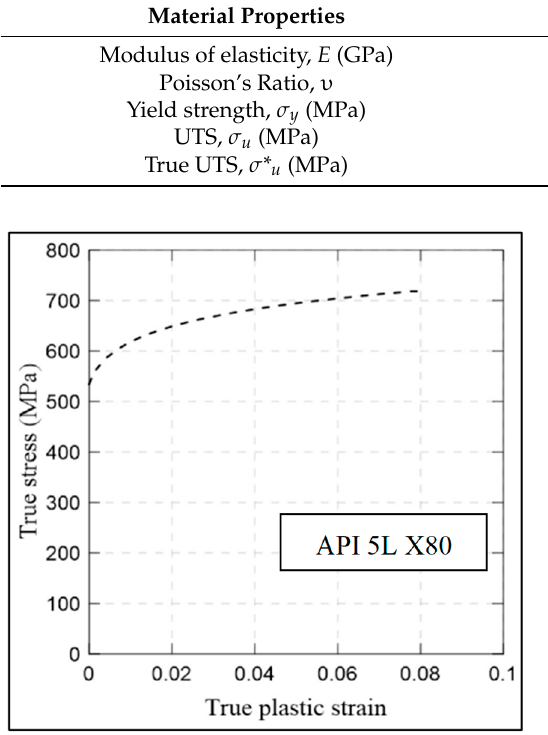
Figure 5. True stress-strain curve for API 5L X80.